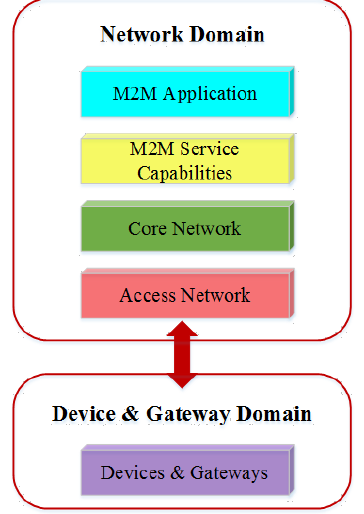
Figure 5. ESTI Reference